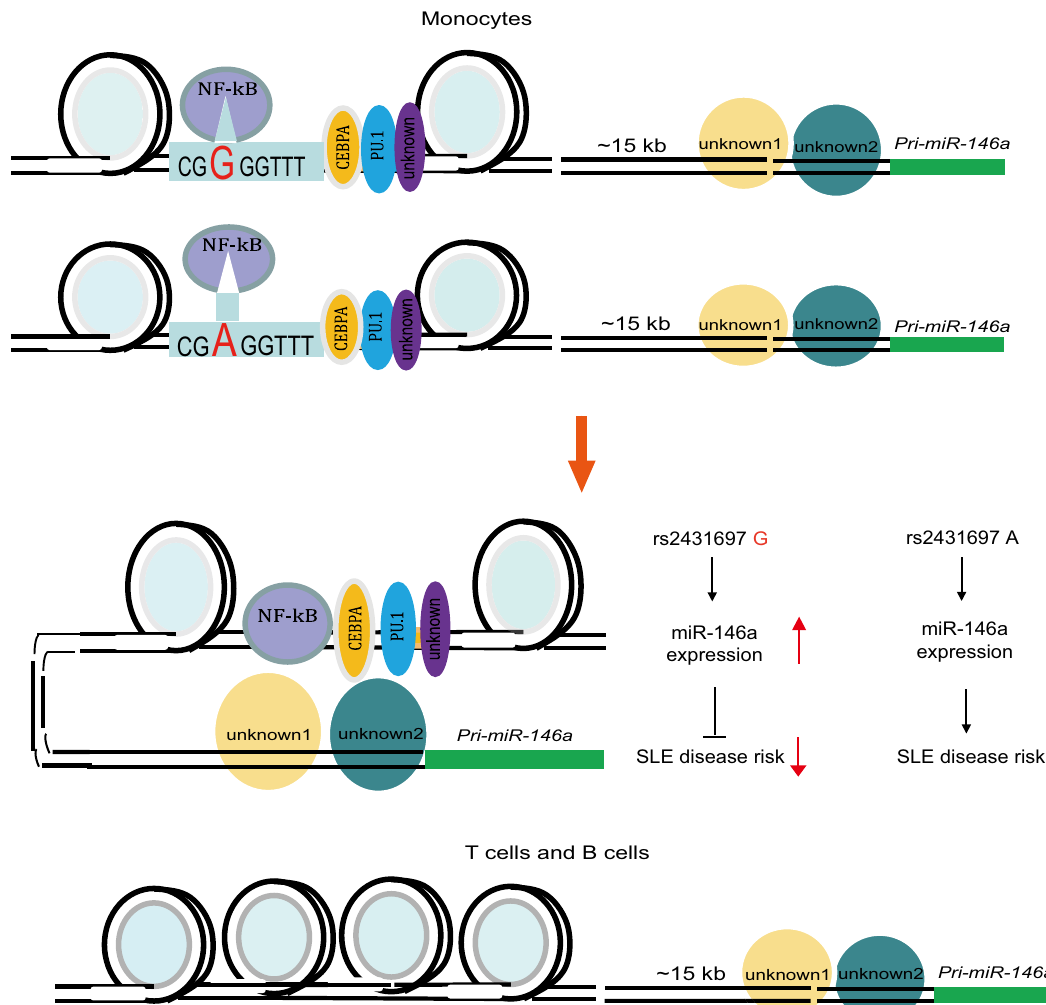
Fig. 7 A model of rs2431697 regulating miR-146a expression in a cell-type-dependent manner. Lineage-determining transcription factor PU.1 or other transcription factors shape the cell-speci fi c enhancer at the rs2431697 locus and NF- κ B acts as a stimulating transcription factor by binding to the genomic sequence harboring rs2431697. The rs2431697 A risk allele has lower NF- κ B-binding af fi nity than the non-risk G allele, resulting in the reduction of miR- 146a expression and increased SLE